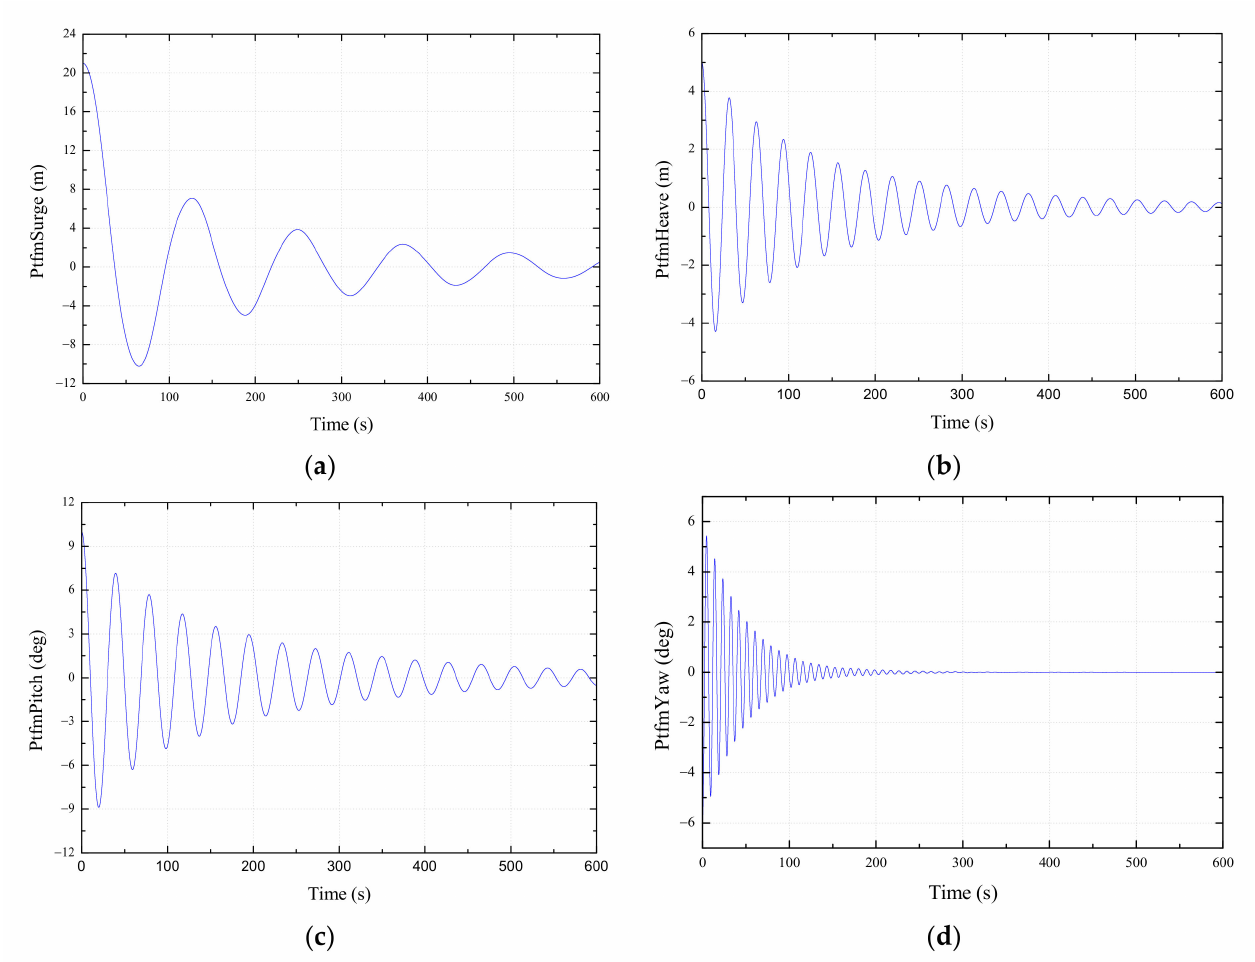
Figure 7. Time series of free decay tests: ( a ) Platform surge motion; ( b ) Platform heave motion; ( c ) Platform pitch motion; ( d ) Platform yaw motion. Table 5. The natural periods of the IEA 10-MW spar type FOWT from decay tests.